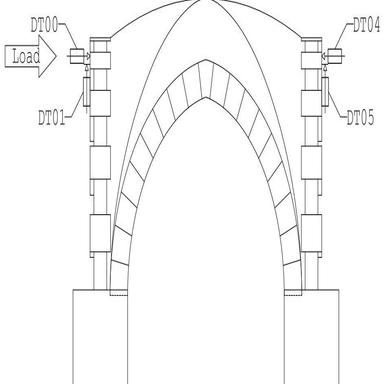
Displacement transducers monitoring the vertical and horizontal displacements of the keystones.